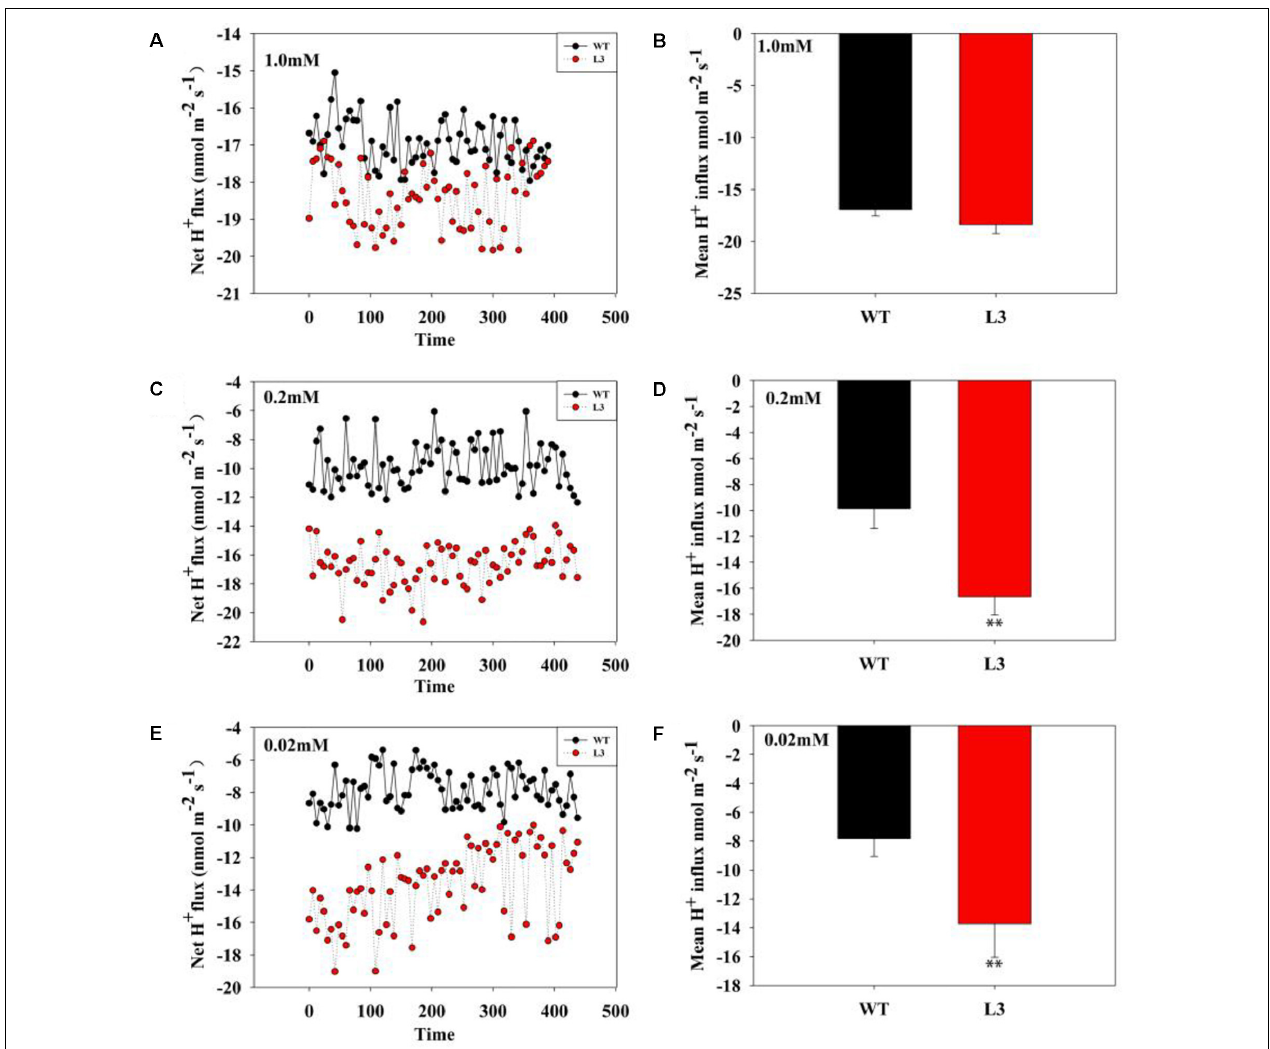
FIGURE 7 | H + flux in tomato roots under variable Pi conditions. (A,C,E) Transient net flux of H + in the root elongation zone of WT plants and three codA -transgenic tomato lines under different Pi concentrations. A continuous flux recording over 10 min was conducted in a corresponding measuring solution (pH 6.0). (B,D,F) The mean rate of H + flux within the measuring periods is shown. Values are means ± SD. n = 6 for each genotype. Asterisks indicate significant differences compared with WT plants (Student’s t -test). ∗ P < 0.05; ∗∗ P <